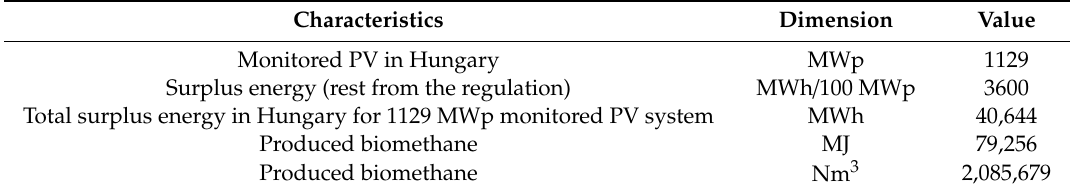
Table 3. Characteristics of the gas produced by the power-to-gas procedure.